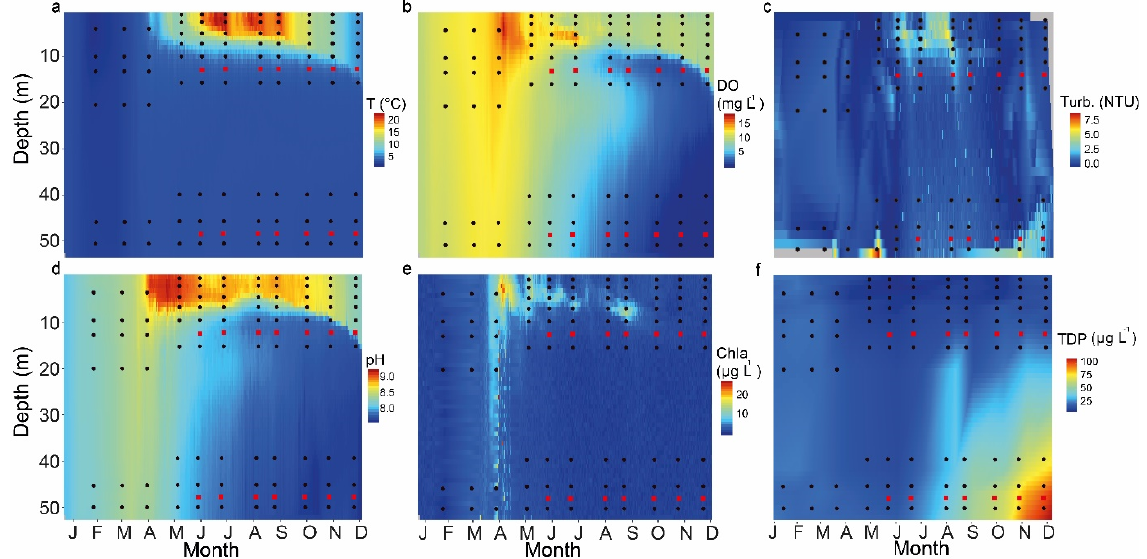
Figure 2. Physicochemical parameters from Lake Tiefer See: Heatmaps of physicochemical parameters for 2019 measured using a multi-parameter water quality probe in the water column of Lake Tiefer See showing ( a ) Temperature (T); ( b ) Dissolved oxygen (DO); ( c ) Turbidity (Turb.); ( d ) pH; ( e ) Chlorophyll-a (Chl a ), and ( f ) Total dissolved phosphorus (TDP). Data are interpolated for 1 d and 1 m water depth. Black circles and red squares represent the depths and timing of sampling of water and sediment traps, respectively.